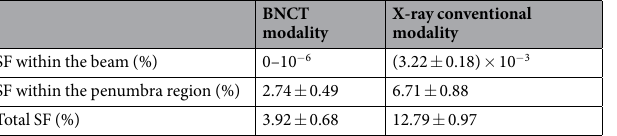
Table 2. Survival fractions (SFs) in different regions for homogeneous-hypoxic circular MEP model for BNCT and conventional photon modalities.